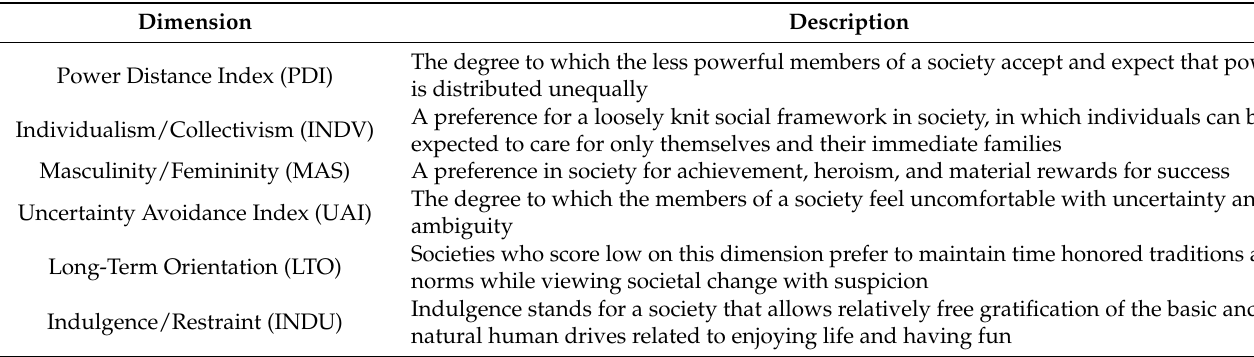
Table 1. Descriptions of the dimensions in Hofstede’s 6-D